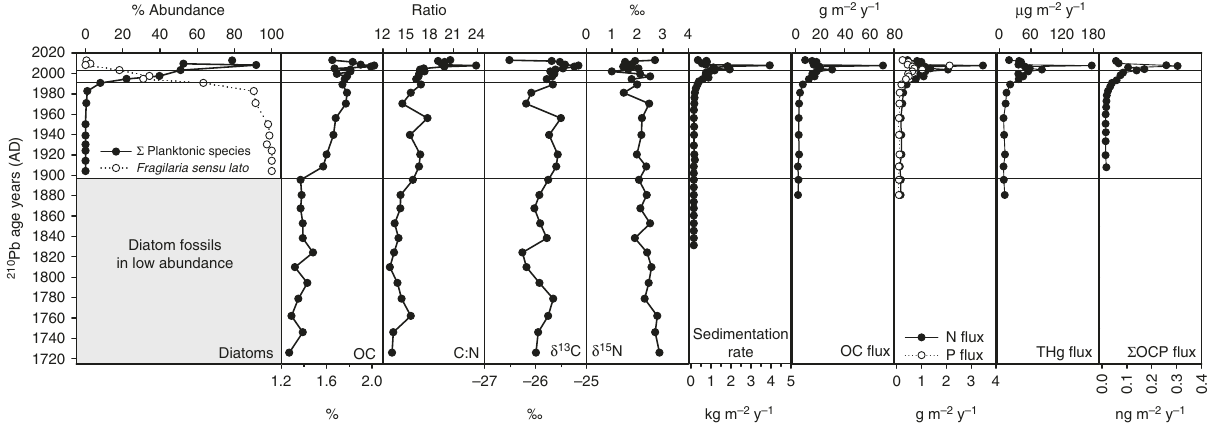
Fig. 5 Sediment record of diatom abundance, geochemical parameters, contaminants and sedimentation rates. Diatom, geochemical and contaminant analyses were completed on three separate sediment cores collected in close proximity in May 2013 from the deepest location in Lake Hazen 10 . One of these cores was used for 210 Pb radiometric dating (also see Supplementary Fig. 7) and calculation of sedimentation rates. This same core was analyzed for organic matter geochemistry and multi-element concentrations. OC organic carbon, C carbon, N nitrogen, P phosphorus, THg total mercury, OCP organochlorine pesticides. See Supplementary Fig. 4 for sediment concentration pro fi les of N, P and contaminants. The horizontal lines demarcate when diatoms fi rst appear in the paleolimnological record in signi fi cant numbers (bottom), when the relative abundance of planktonic diatom species fi rst began to increase (middle) and then surpassed that of benthic species (top)